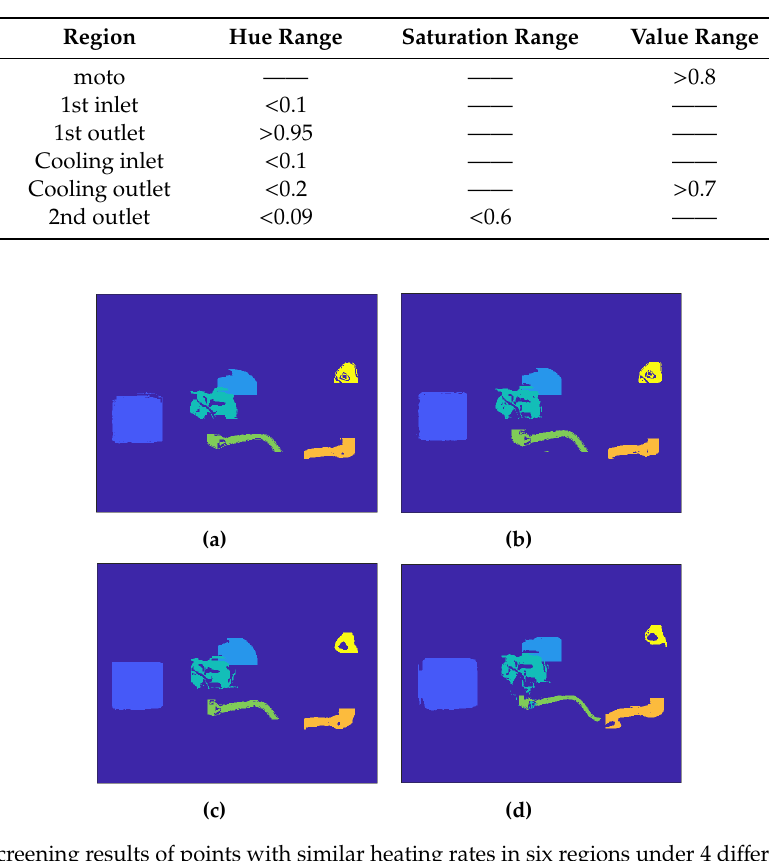
Figure 7. Comparison of the average grayscale values between six regions under different operating conditions ( a – f ). 3.2. Fault Type Classification Using Support Vector Machine (SVM) Although there are clear differences between the grayscale values for the entire operating process, it is not easy to use a simple method to differentiate the four cases. This study chooses a